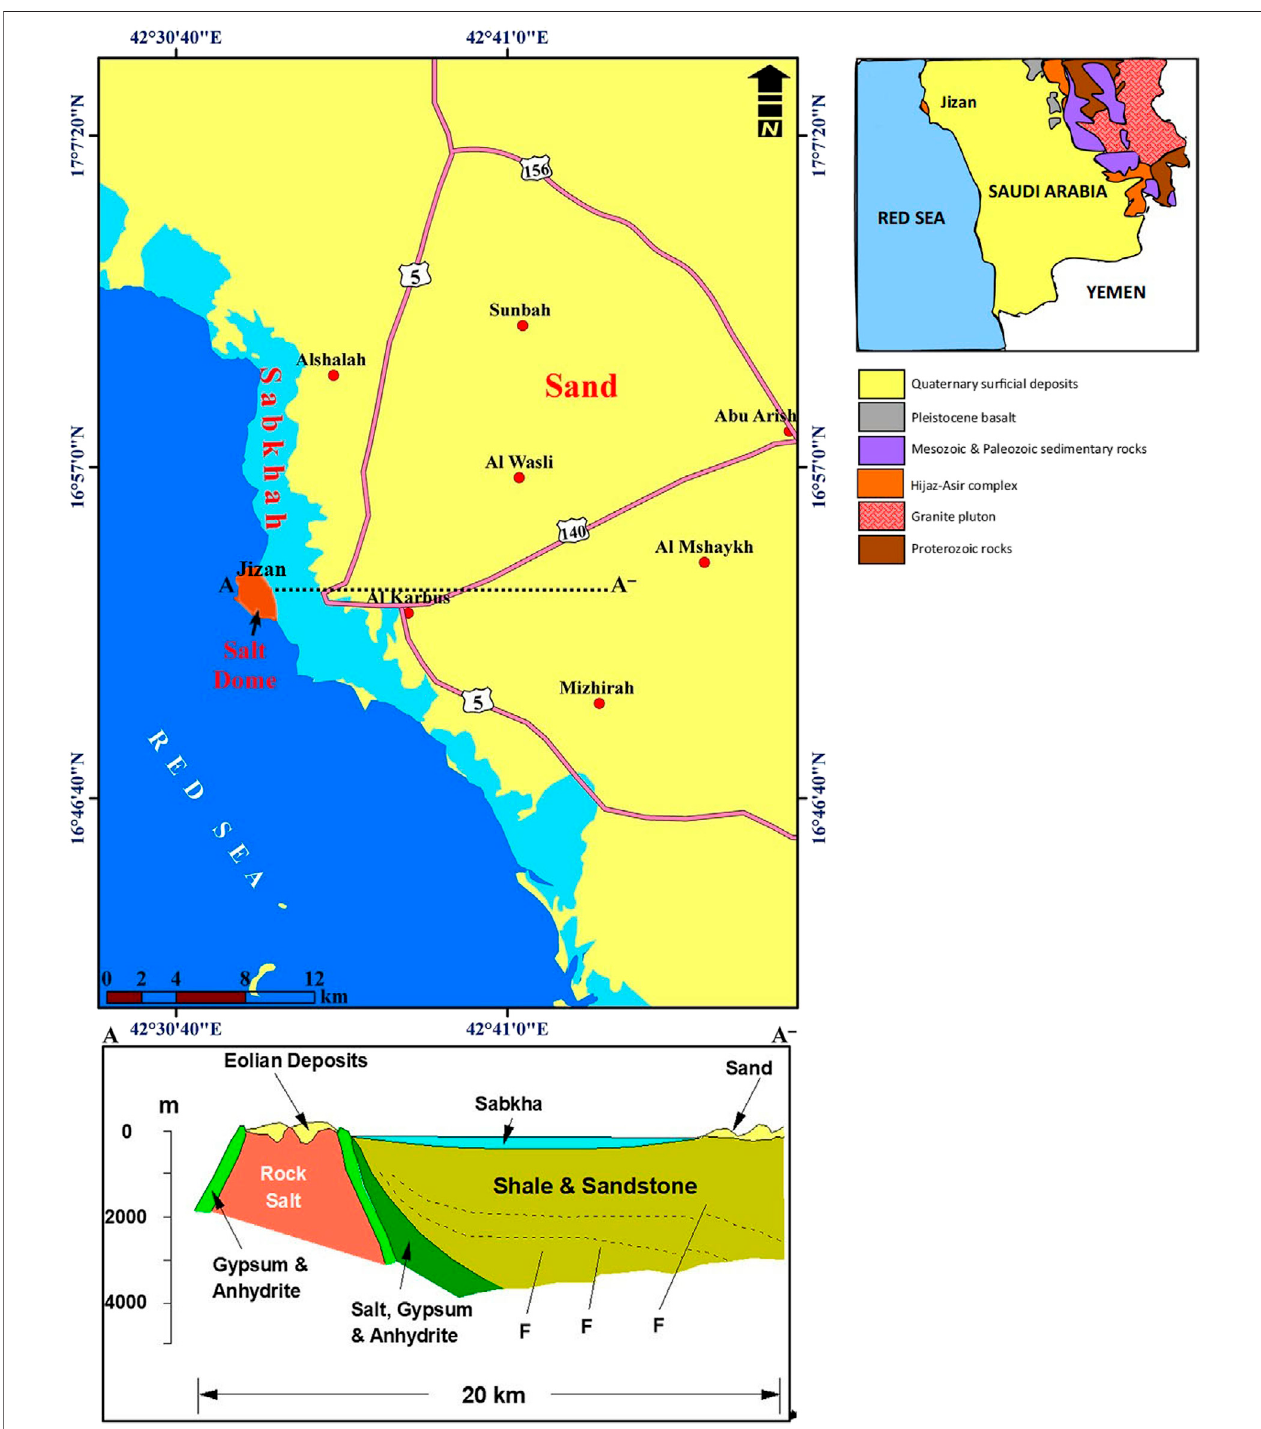
FIGURE 2 | Geologic map the study area where the geologic cross-section is drawn on the map (Alhumimidi, 2020).